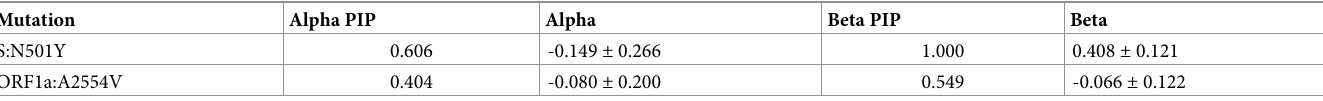
Table 4. Top vaccination-dependent